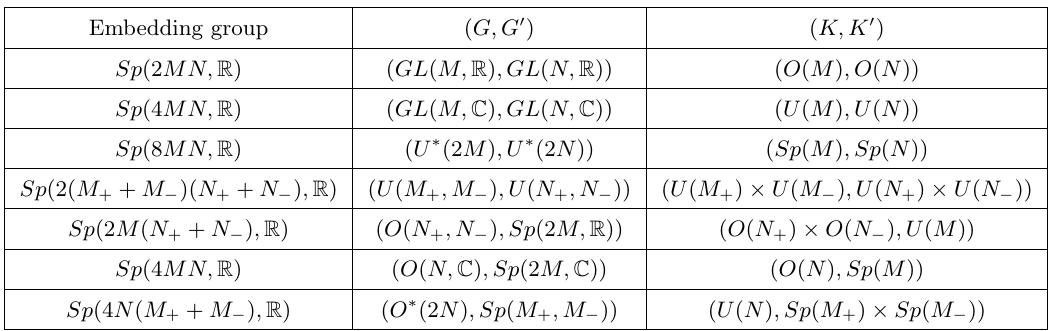
Table 1 . List of all possible irreducible reductive dual pairs ( G; G 0 ) embedded in metaplectic groups and their respective maximal compact subgroups ( K; K 0